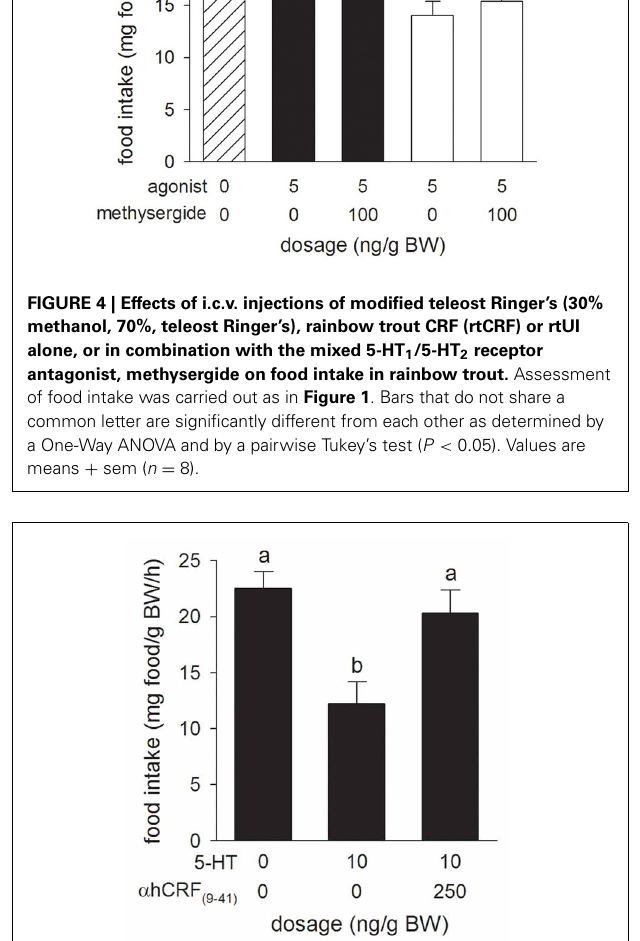
FIGURE 5 | Effects of i.c.v. injections of teleost Ringer’s (0.2% NaHCO 3 in 0.6% NaCl) or serotonin (5-HT) alone, or in combination with the CRF receptor antagonist, α -helical CRF ( 9 – 41 ) ( α hCRF ( 9 – 41 ) ) on food intake in rainbow trout. Assessment of food intake was carried out as in Figure 1 . Bars that do not share a common letter are significantly different from each other as determined by a One-Way ANOVA and by a pairwise Tukey’s test ( P < 0 . 05). Values are means + sem ( n =